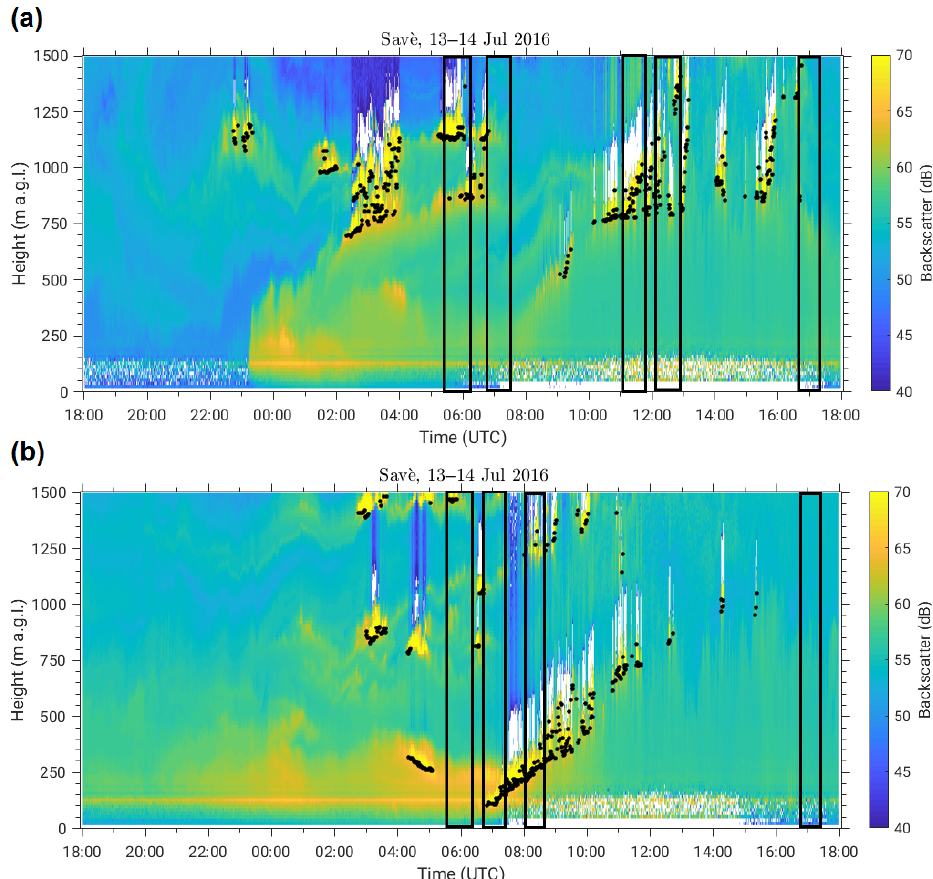
Figure 6. Backscatter signal of the KIT ceilometer (Handwerker et al., 2016) installed at the Savè supersite between (a) 18:00UTC on 13 July 2016 and 18:00UTC on 14 July 2016 as well as (b) in the period of 18:00UTC on 14 July 2016 to 18:00UTC on 15 July 2016. On 14 July, different layers of atmospheric particles were observed during the day. At midday, clouds were detected at 800ma.g.l. and dissolved at 18:00UTC. On 15 July, low-level clouds occurred at 07:00UTC in the lowermost 200ma.g.l., lifted up to the height of 750ma.g.l. at 11:00UTC, and dissolved in the afternoon at 14:00UTC in the lowermost 1.5km. The black boxes indicate the flight periods of the UAS